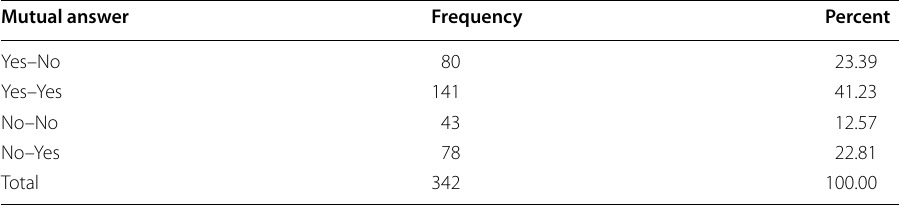
Table 3 Sample households’ joint answer frequency . Source: Author’s computation, 2021